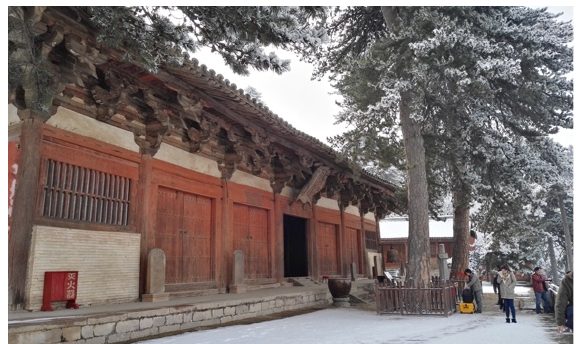
Figure 2. The front façade of the east great hall of FKS.